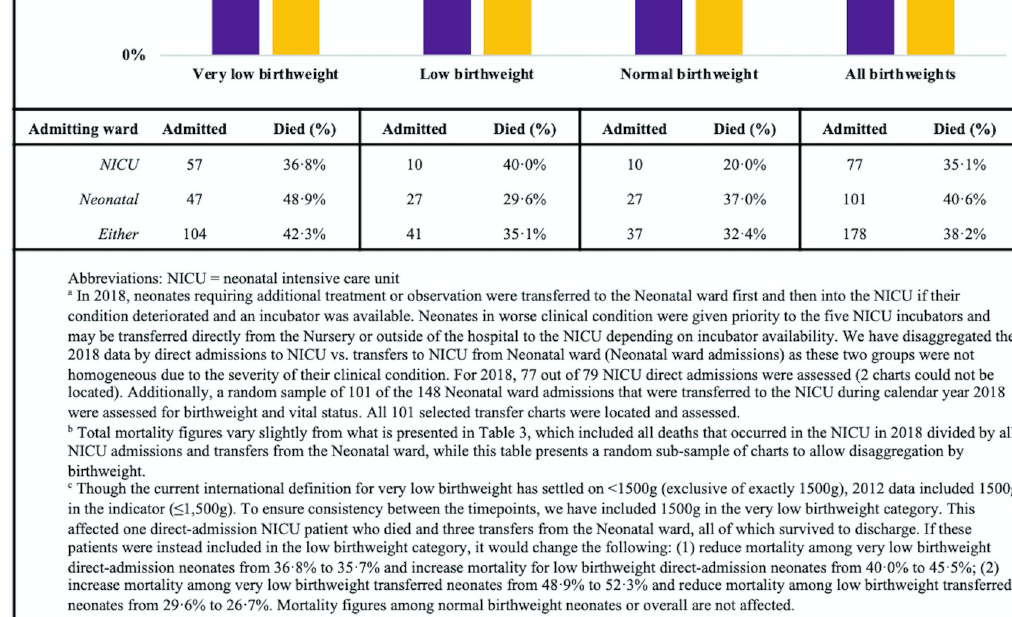
recent meta-analysis reporting an incidence density rate of neonatal mortality of 24.5 in NICU wards compared to 1.2 within the larger population [23]. The addition of a NICU, first brought to Lesotho through the PPP, was important and likely drove initial increases in neonatal admissions (246 in 2012). A less intensive Neonatal ward was then opened and experienced a surge in admissions (1,439 combined NICU, Neonatal ward, and Nursery admissions in 2018). While neonatal mortality overall decreased between the timepoints, NICU mortality rate at QMMH remains far above those achieved in most high-income countries, though simi- lar to other LMICs including Uganda, India, Iran, and Nepal [24]. Mortality reviews may help